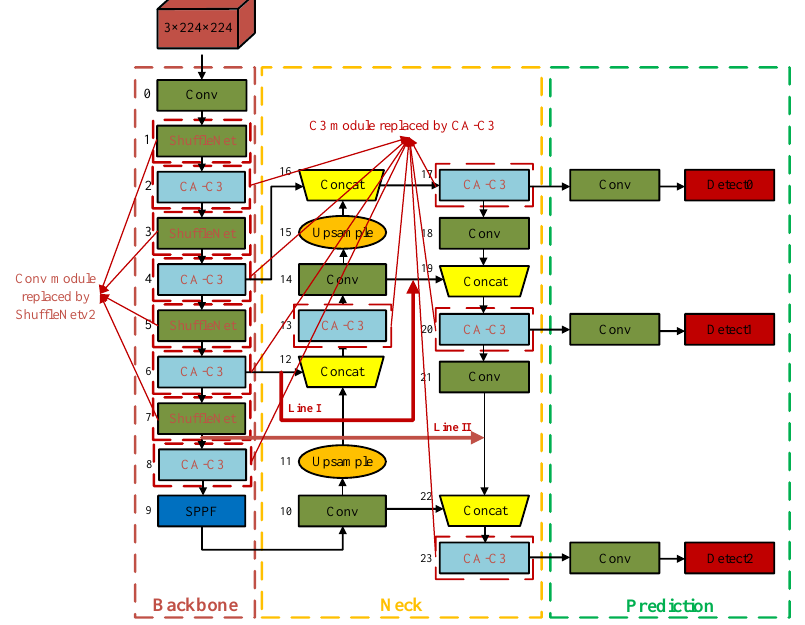
Figure 6. The architecture of improved YOLOV5.